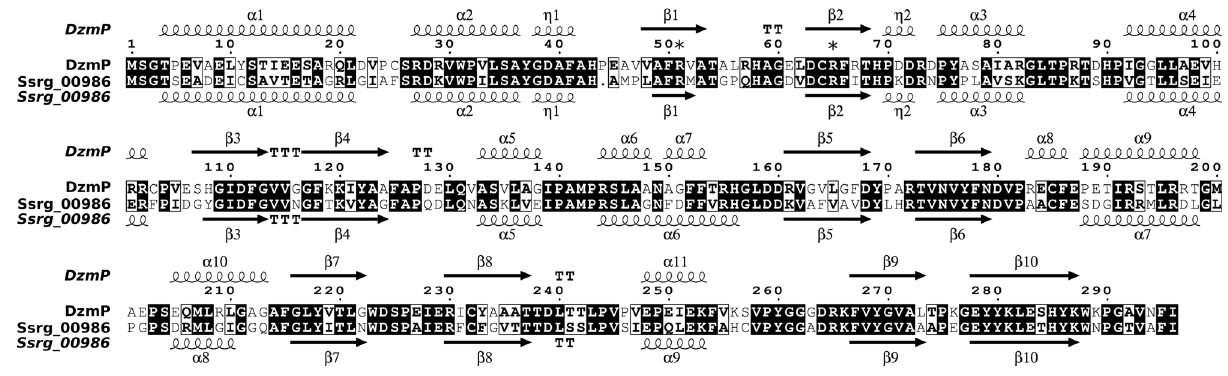
Figure 4. Amino acid alignment und secondary structure prediction for DzmP and Ssrg_00986 visualized by ESPript. [52] . Secondary structure elements are: α, α-helices; η, 3 -helices; β, β-strands; TT, strict β-turns. Strict sequence identity is shown by a 10 black box with white characters, and similarity is shown by bold characters in a black frame. The position of the two arginine residues typical for Mg 2+ -independent ABBA prenyltransferases are indicated by asterisks. doi: